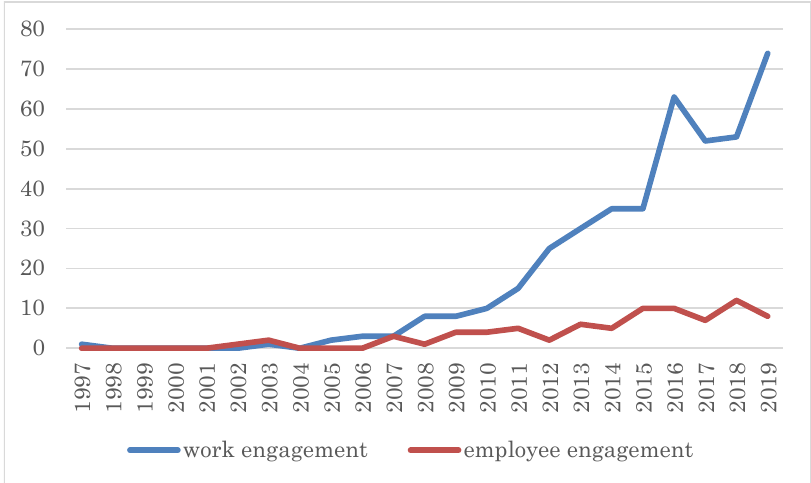
01020304050607080 19971998199920002001200220032004200520062007200820092010201120122013201420152016201720182019 work engagement employee Figure 2. Number of articles with WE or EE in the title (PubMed) 233